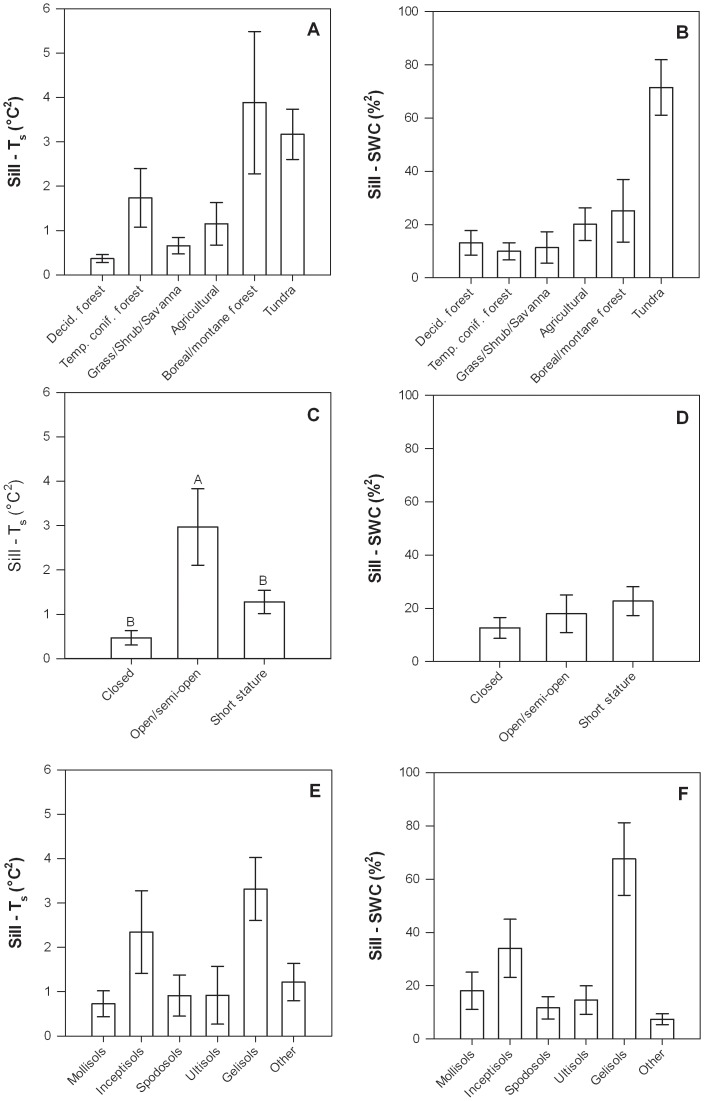
Semivariogram sill for Ts (left column) and SWC (right column) at each site in relation to ecosystem type (a, b), canopy structure (c, d), and soil type (e, f).Error bars represent ±1 SE. Bars with different letter were significantly different (p<0.05) based on Tukey HSD tests. The letter “A” corresponds to the largest least square mean(s) and subsequent letters (B, C, …) correspond to progressively smaller least square means.